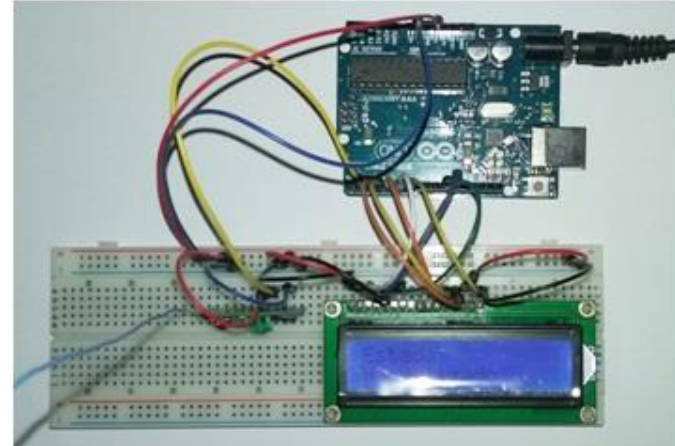
Figura 11: Dispositivo para recebimento e informação. Fonte: Autores, (2018).